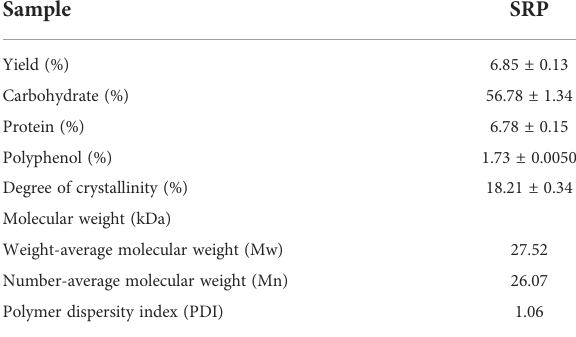
TABLE 4 Physicochemical composition and molecular